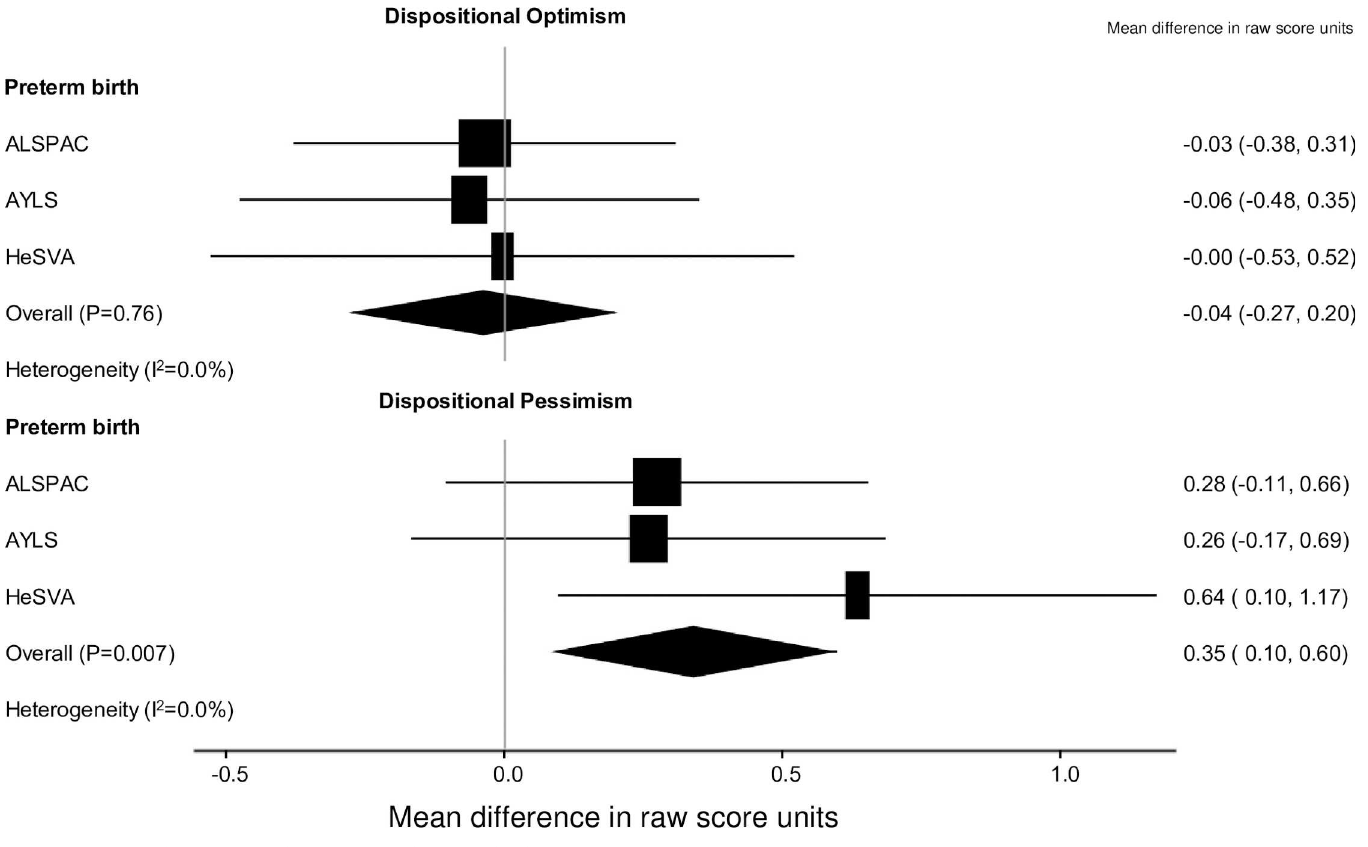
Fig 3. Dispositional optimism and pessimism and preterm birth.